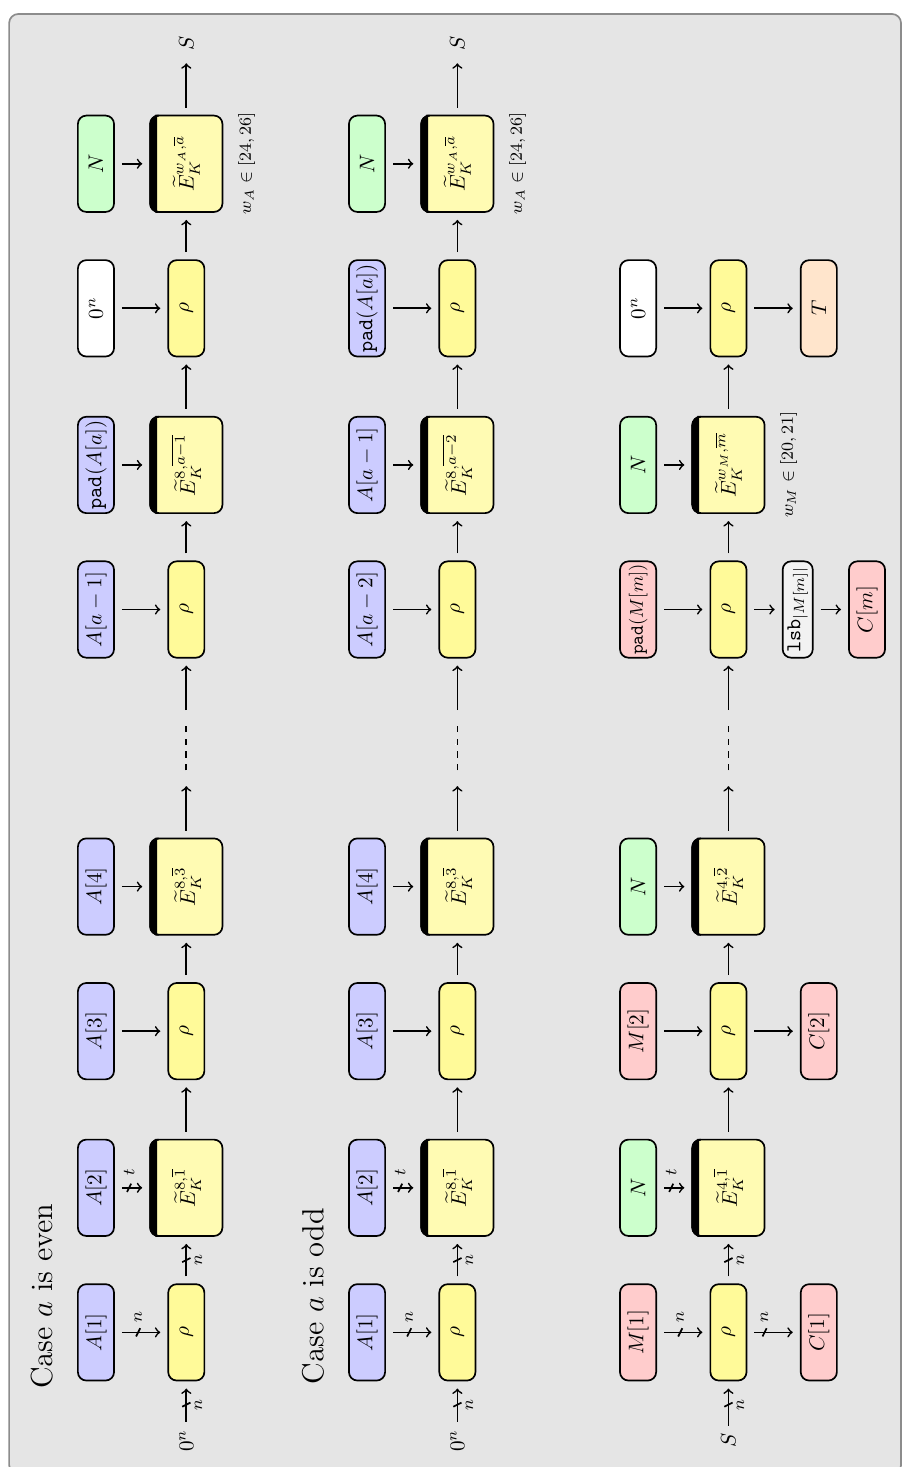
Figure 3: The Romulus-N nonce-based AE mode. (Top) process of AD with an even number of AD blocks. (Middle) process of AD with an odd number of AD blocks. (Bottom) Encryption. We use Romulus - N 1 as working example. For other Romulus-N members, the values of the bits b 7 and b 6 in the domain separation need to be adapted